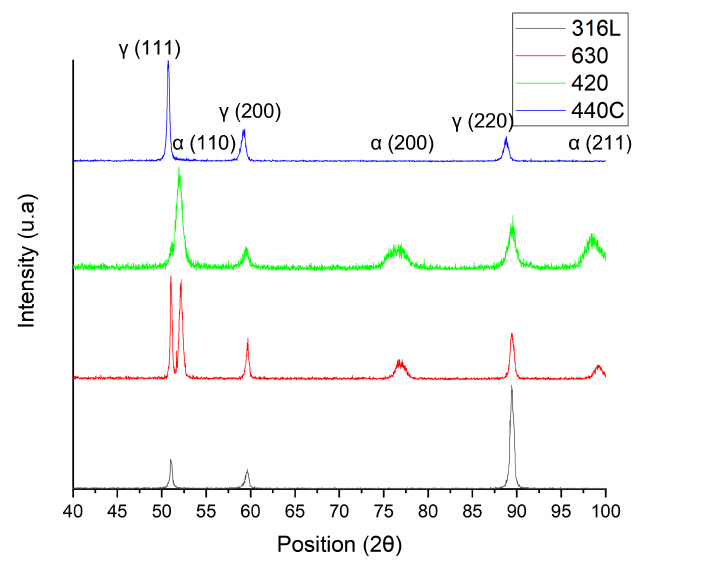
Figure 7. X-ray diffractograms of the 316L, 630, 420 and 440C 3D objects (from bottom to top, respectively).